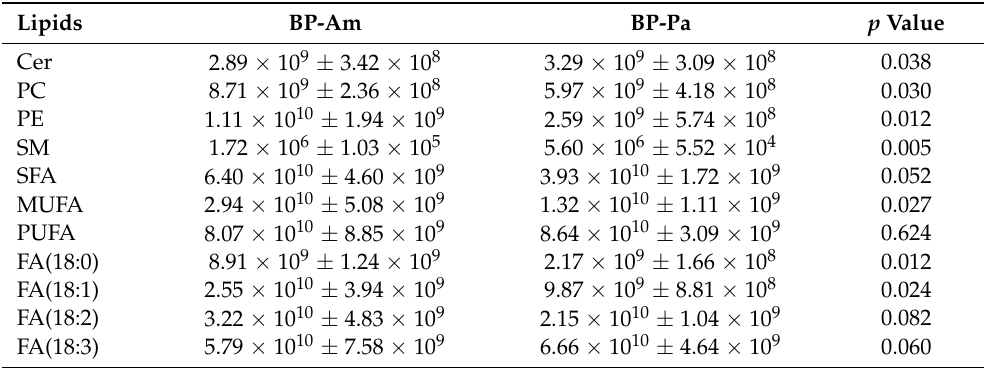
Table 1. Relative abundance of different kinds of lipids in single bee pollen derived from Acer mono Maxim. and Phellodendron amurense